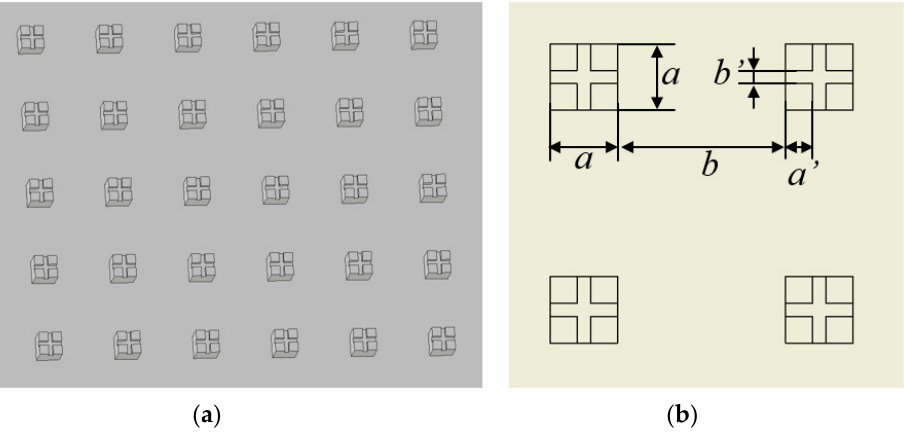
Figure 11. Schematic diagram of the cruciform secondary microstructures. ( a ) is sketch map, ( b ) is drawing of dimensions. In Figure 11, ' a and